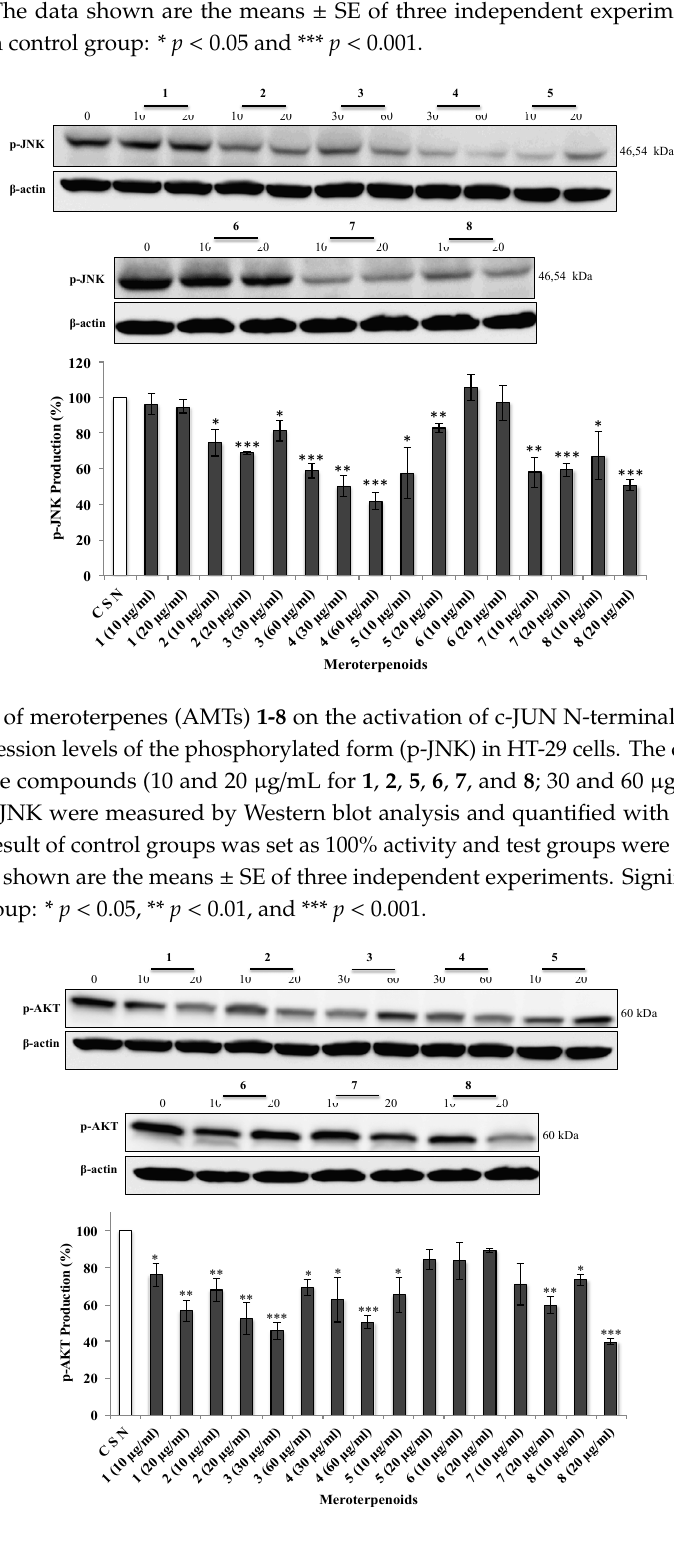
Figure 8. Effect of meroterpene s (AMTs) 1-8 on the activation of protein kinase B (AKT) by measuring expression levels of the phosphorylated form (p-AKT) in HT-29 cells. The cells were treated for 24 h with the compounds (10 and 20 μ g/mL for 1 , 2 , 5 , 6 , 7 , and 8 , and 30 and 60 μ g/mL for 3 and 4) . The levels of p-AKT were measured by Western blot analysis and quantified with Image J analysis software. The result of control groups was set as 100% activity and test groups were compared to this value. The data shown are the means ± SE of three independent experiments. Significant difference from control group, * p < 0.05, ** p < 0.01, and *** p < 0.001.